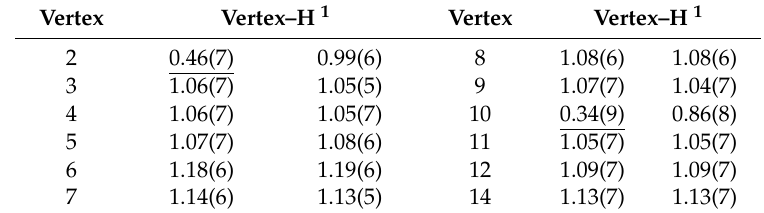
Table 4. Vertex–H distances (/Å) for non-metal vertices in Prostructure of [1,13-Cp 2 - closo -1,13,2,10- Co 2 C 2 B 10 H 12 ]. Vertex Vertex–H 1 Vertex Vertex–H 1 2 0.46(7)